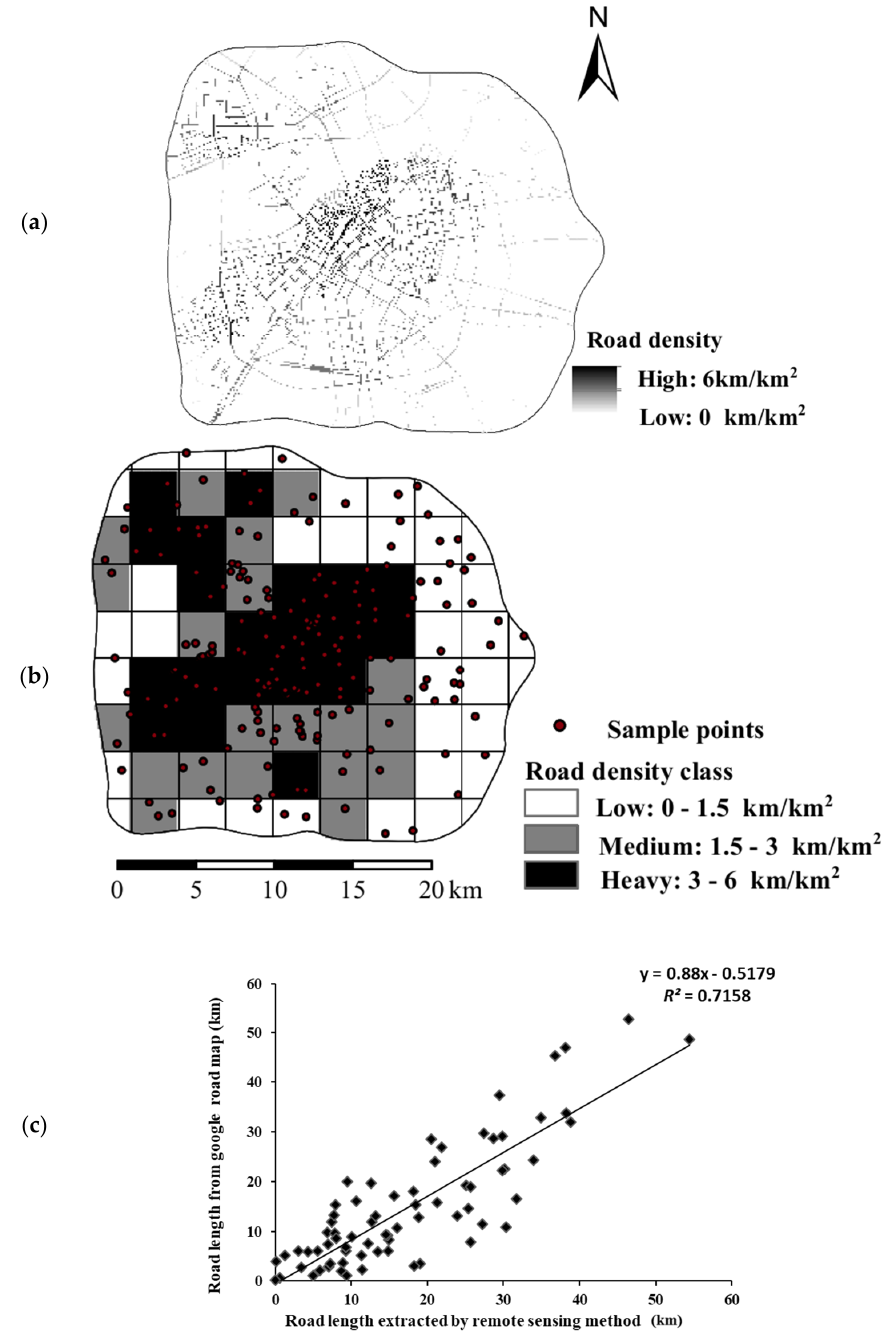
Figure 2. Urban road distribution in Harbin ( a ); classification of low, medium, and heavy road density (RD) regions ( b ); and road extraction precision with reference to Google Roadnet map ( c ).